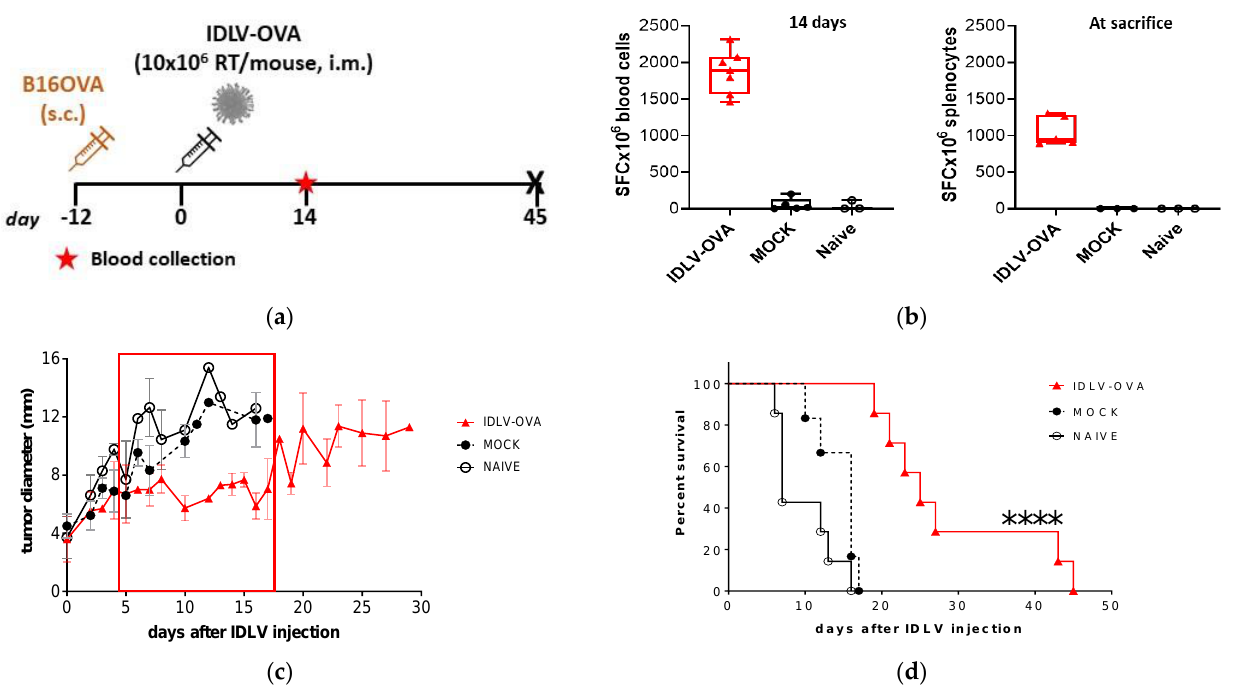
Figure 2. Therapeutic efficacy of IDLV-OVA vaccination in B16OVA-bearing mice. ( a ) Scheme of the experiment. C57BL/6 mice were s.c. injected with 2 × 10 5 B16OVA cells/mouse. After 12 days, groups of mice were vaccinated either with 10 × 10 6 RT/mouse of IDLV-OVA or IDLV expressing an unrelated antigen (mock) or left untreated (Naïve). ( b ) OVA-specific T cell response was generated in all IDLV-OVA immunized mice, as evaluated by IFNγ ELISpot measured two weeks after immunization in blood cells (left panel) and at sacrifice in splenocytes (right panel). Cells were collected and stimulated with H-2Kb restricted OVA 8mer peptide (SIINFEKL). Data are expressed as spot forming cells (SFC) per million cells. ( c ) Tumor growth. All groups developed a tumor mass measured until the end of the experiment. The delay of tumor growth in IDLV-OVA immunized mice is highlighted with the red rectangle. Mock and Naïve groups were sacrificed within 18 days from tumor injection. ( d ) Kaplan–Meier survival curve. Mice with tumor diameter >15 mm or a serious ulceration were sacrificed. (Log-rank Mantel-Cox test, **** p < 0.0001).